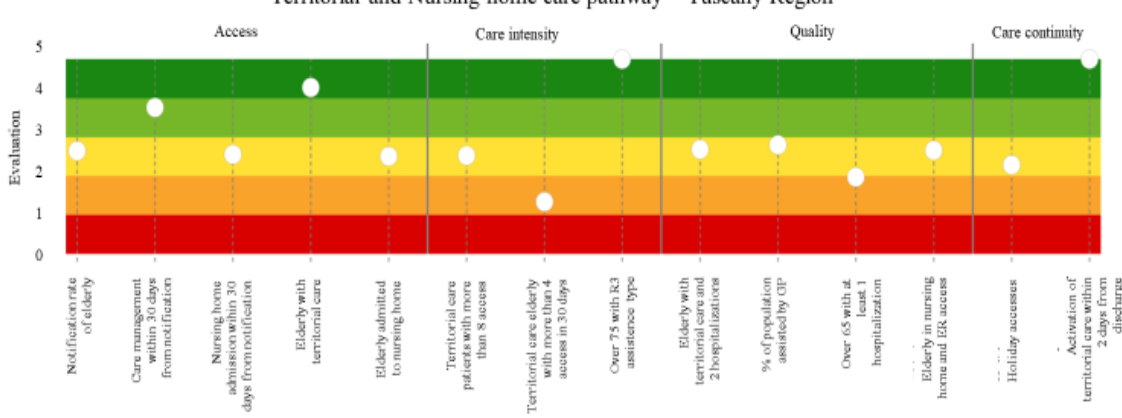
Figure A2. The pentagram of nursing home and home-delivered care pathway, Tuscany Region, 2018. Color bands are horizontal, framing the different stages of care pathways, and pa-